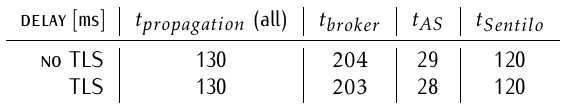
Table 5. Transmission